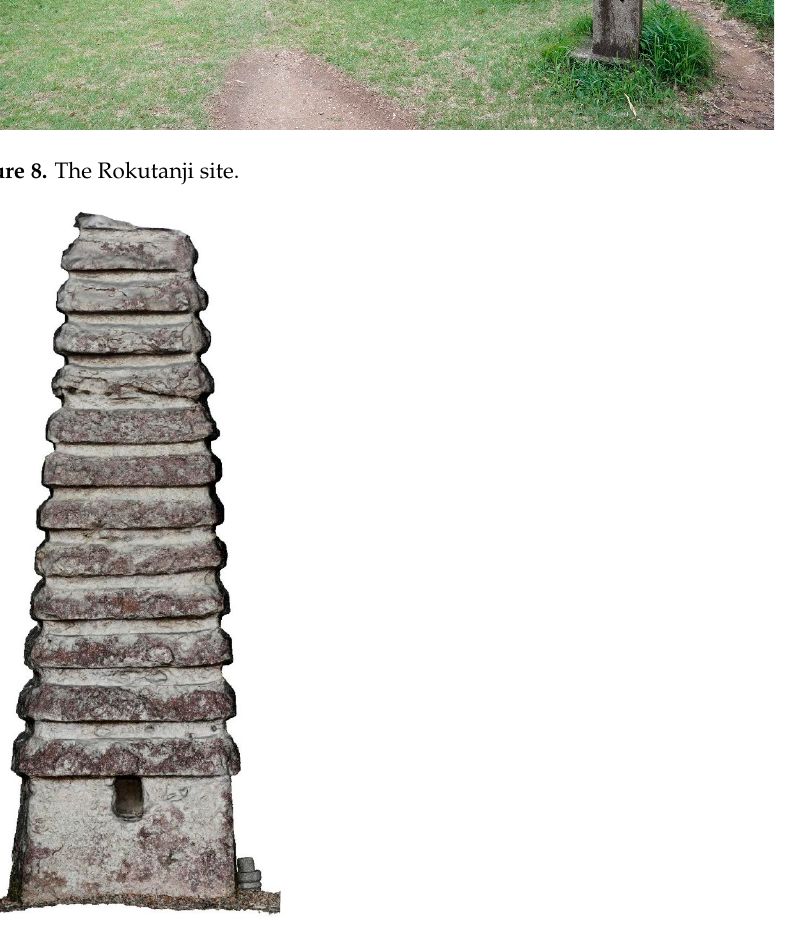
Figure 9. 3D model of Rokutanji’s 13-story pagoda (provided by Honma Takehito). Rokutanji’s main object of veneration was likely the nyorai triad that is line - carved (Skt. Maitreya ) triad (Fujisawa 1985), or Amida 阿弥陀 (Skt. Amitâbha ), Shakamuni 釈 迦牟尼 (Skt. Śā kyamuni ), and Yakushi 薬師 (Skt. Bhai ṣ ajyaguru ) (Nishimura 1942). Taket-